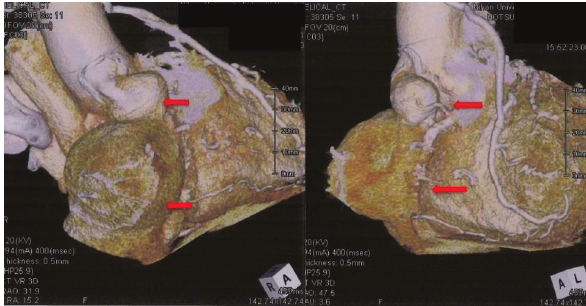
Figure 4: ein graft aneurysm on admission in 3D computed tomogra- phy (volume rendering image). Saphenous vein graft aneurysms with diameters of 27 mm and 64 mm, respectively, were found from the head side position in front of the right atrium (red arrows).